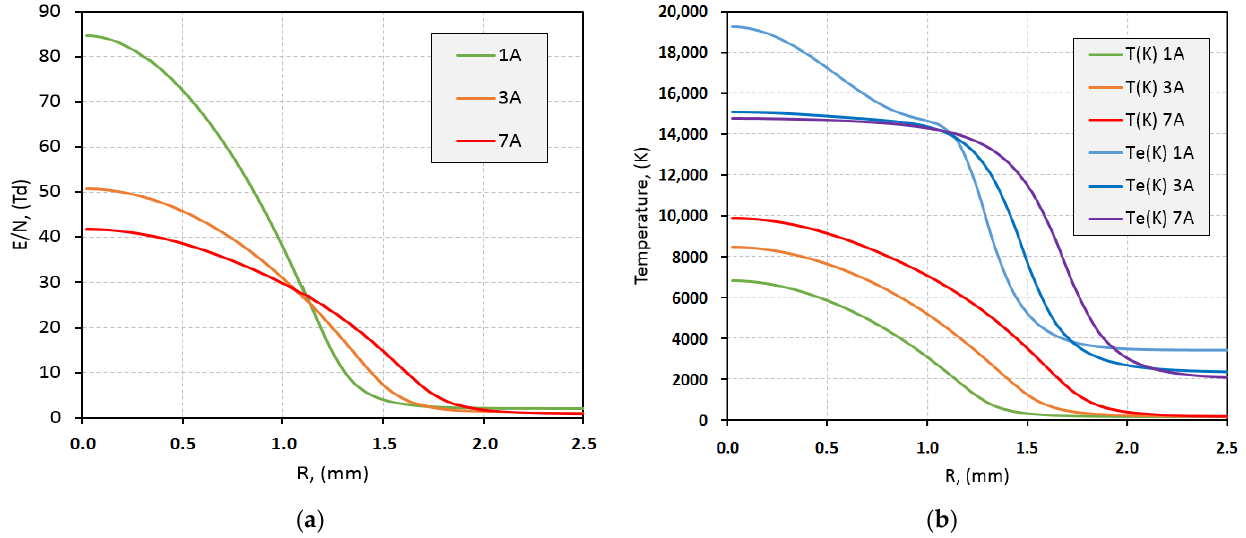
Figure 8. Radial profiles at a distance of 15 mm from the upstream electrode of E/N ( a ) and temperature/electron temperatures ( b ) for different currents obtained by Plasmaero.